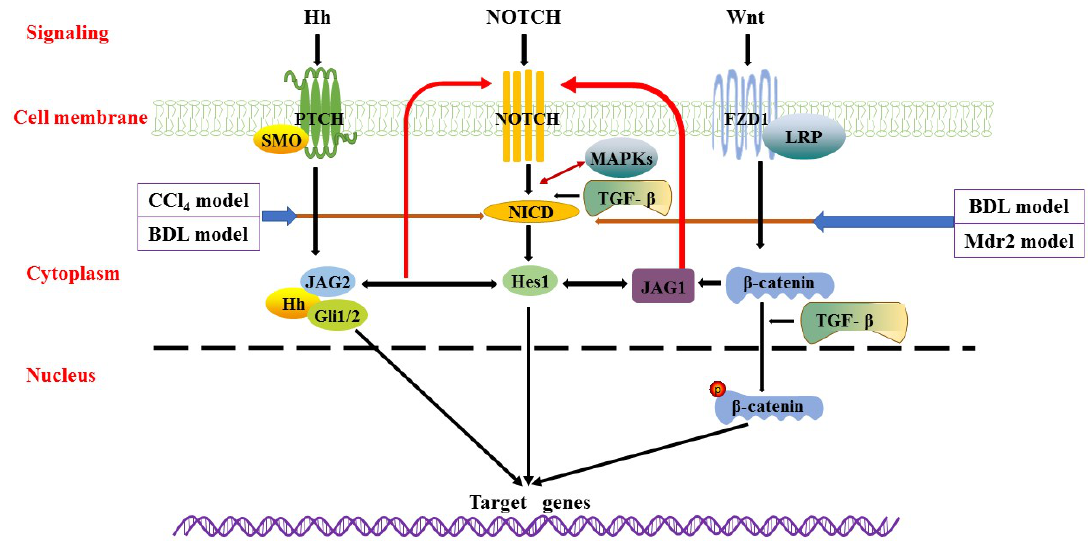
Figure 2. Wnt/ β -catenin, Notch, and Hedgehog signalling pathways. Wnt/ β -catenin signalling is transmitted through the Frizzled (FZD) receptor, thereby stabilizing β -catenin. Phosphorylated β -catenin translocated into the nucleus to regulate the expression of target genes. There is crosstalk between Wnt/ β -catenin signalling and Notch/TGF- β signalling. In Notch signalling, binding of Notch ligands to the receptor results in two proteolytic cleavages to release NICD. The released NICD then translocated into the nucleus, activating transcription factors Hes1, JAG1, and JAG2, whilst the Notch signal pathway interacts with Hh and Wnt signalling pathways. In Hedgehog signalling, Hh ligand secreted by Hedgehog secretory cells binds to PTCH or SMO and generates activated Gli that translocated to the nucleus, inducing target gene expression. These main survival pathways and sophisticated interactions between signalling pathways (i.e., TGF- β and MAPKs) constitute a complex regulatory network for the survival and proliferation of BECs.